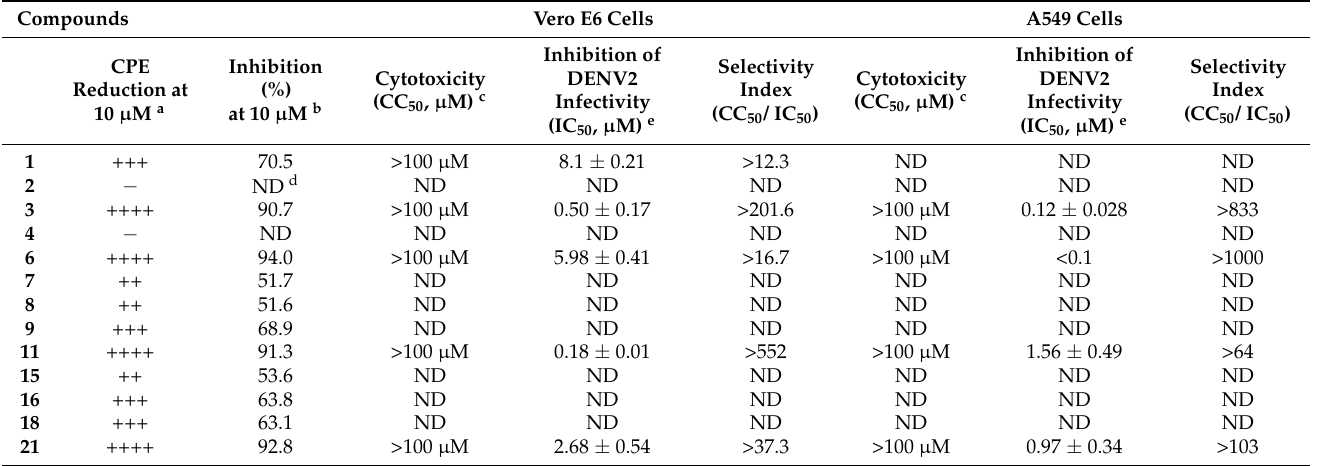
Table 1. Antiviral activity of Glycyrrhizic acid derivative against Dengue virus type